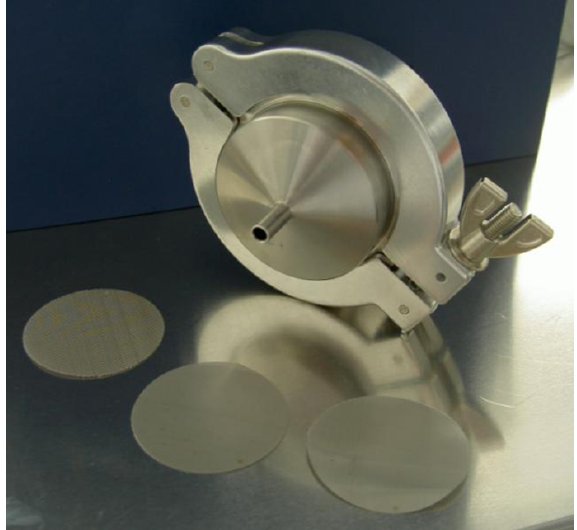
Fig. 4. Picture of the diffusion screens (foreground) and a stainless steel screen holder